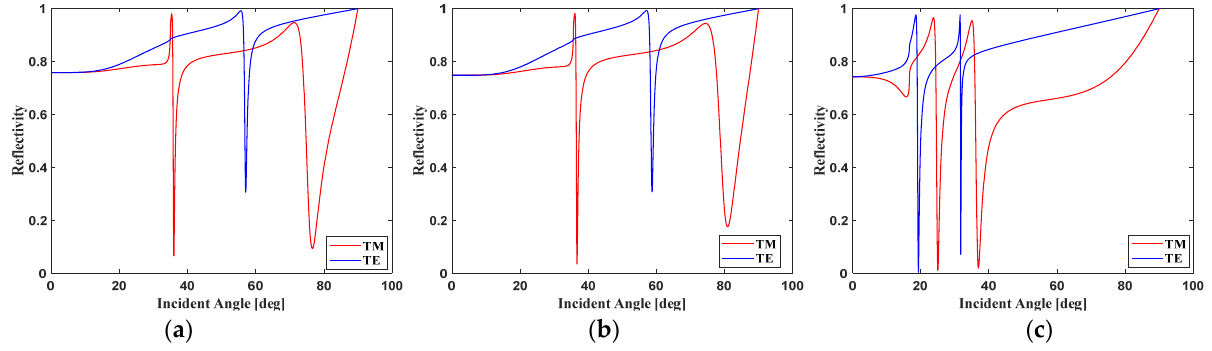
Figure 2. The theoretical plots of the reflectivity versus incident angle for TM (red) and TE (blue) polarized incident light of the GA–optimized CPWR structures: ( a ) sapphire prism/29.42 nm TiN/909.83 nm AlN/air, ( b ) magnesium oxide prism/28.33 nm TiN/909.50 nm AlN/air, and ( c ) silicon prism/28.33 nm TiN/711.88 nm AlN/air.